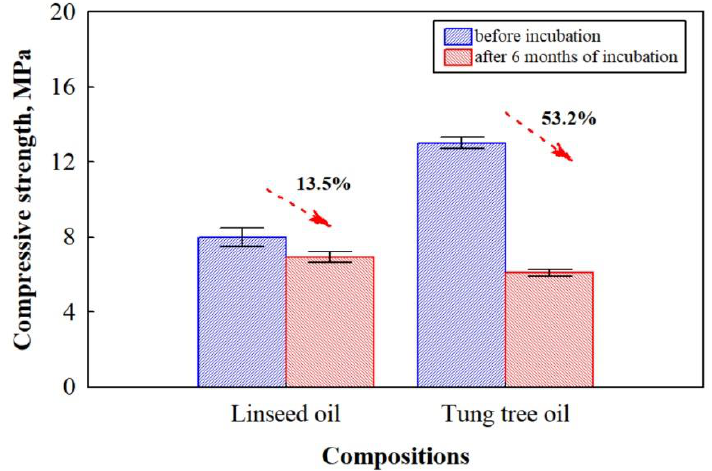
Figure 8. Compressive strength of biocomposites based on HS and CS and impregnated with different oils before and after 6 months of incubation.